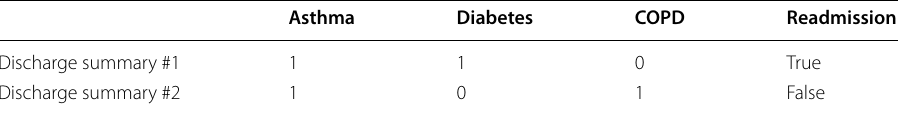
Table 1 Example bag-of-words representation Asthma Diabetes